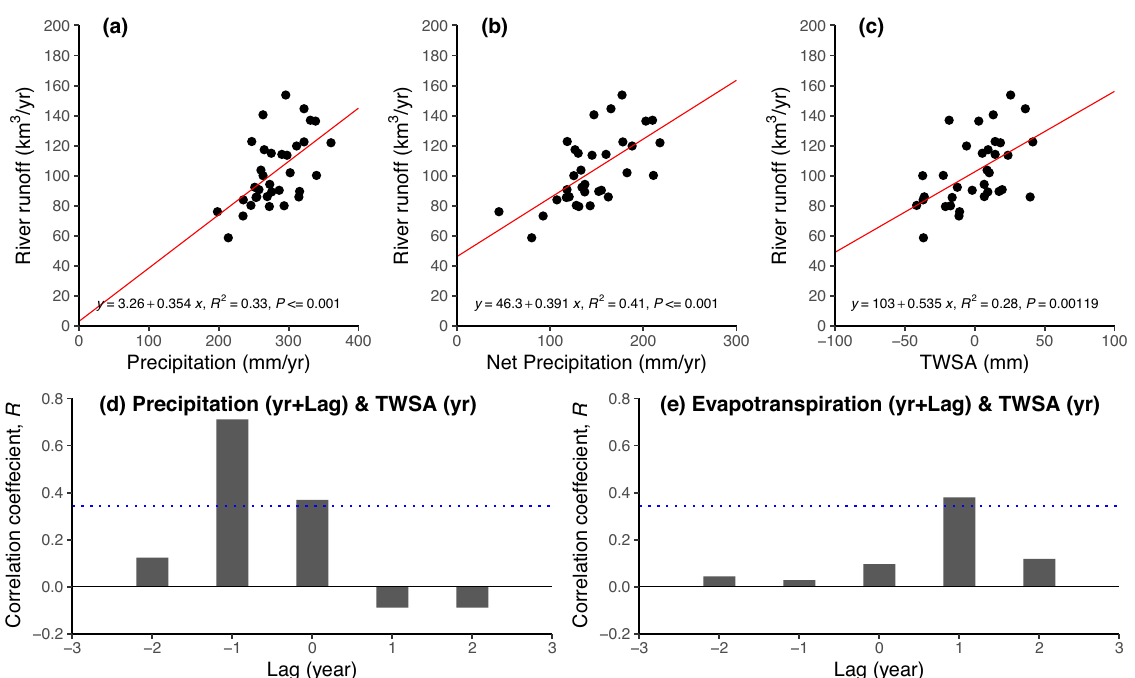
Figure 12. Relation between annual river runoff and related annual factors: ( a ) Precipitation, ( b ) Net precipitation (P-E), and ( c ) Terrestrial water storage anomaly (TWSA). Here, we used CHANGE-based evapotranspiration and TWSA; ( d , e ) Show lag correlation coefficients (R) between TWSA and precipitation and evapotranspiration, respectively. Lag year indicates precipitation and evapotranspiration against the target year of TWSA. Negative and positive lag denote that the lag year advanced and delayed from the target year of TWSA,